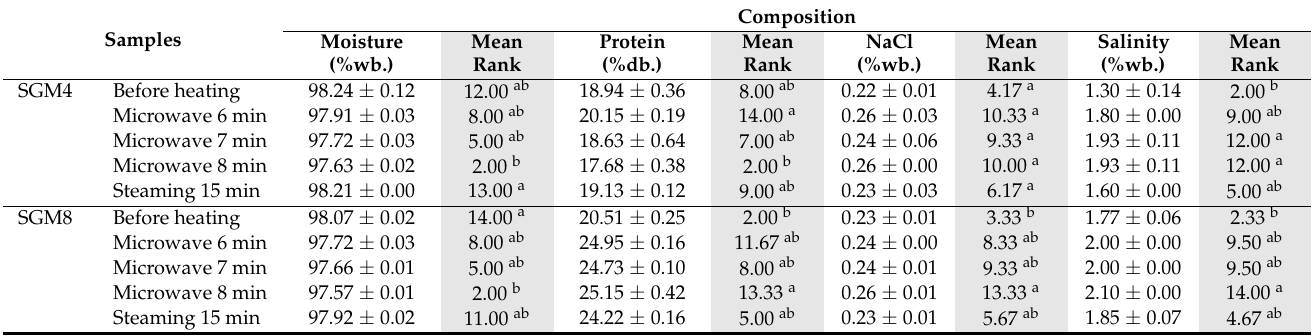
Table 1. Moisture, protein, and sodium contents of SGM4 and SGM8 before and after heat treatments.